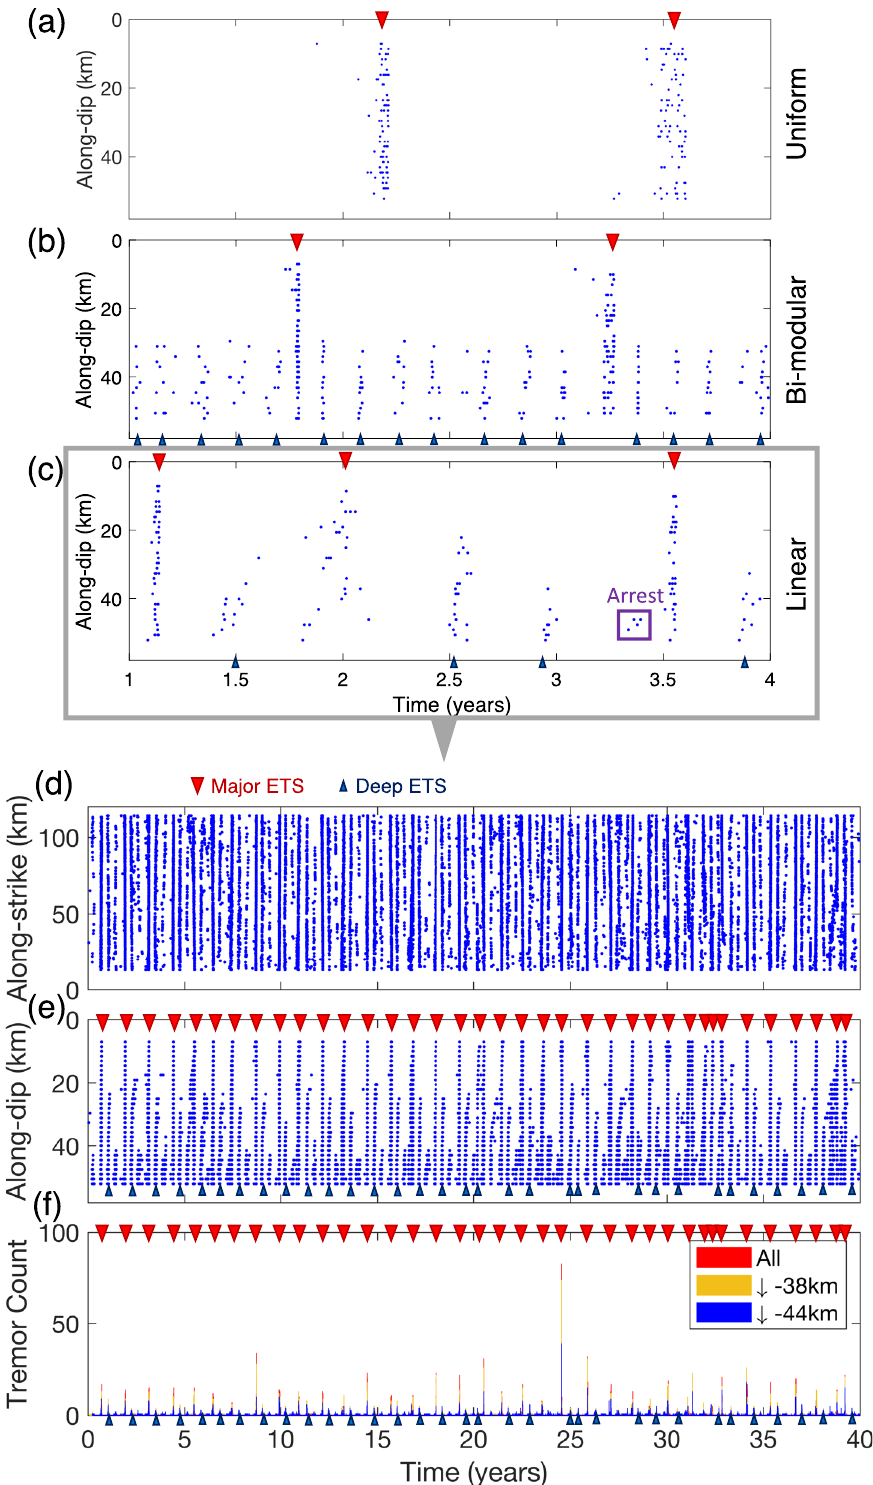
Fig. 5 Rate-and-state model results. a – c Simulated tremor activities from three asperity-in-matrix (AIM) models with slip-rate detection threshold of 10 4 V (tectonic loading rate). a Uniform model, b bi-modular model, and c linear model. d – f Forty years simulation results of the linear model with d strike- pl and e dip-parallel projection, f tremor activities binned in 5-day window. Major ETS (episodic tremor and slow-slip, red triangles) with approximately 13 months recurrence and interspersed deep and arrested ETS (blue triangles) with interval of months. The spatiotemporal patterns of simulated ETS are in strikingly good agreements with the observations in northern Cascadia (e.g., Fig. 1b), see also Fig.